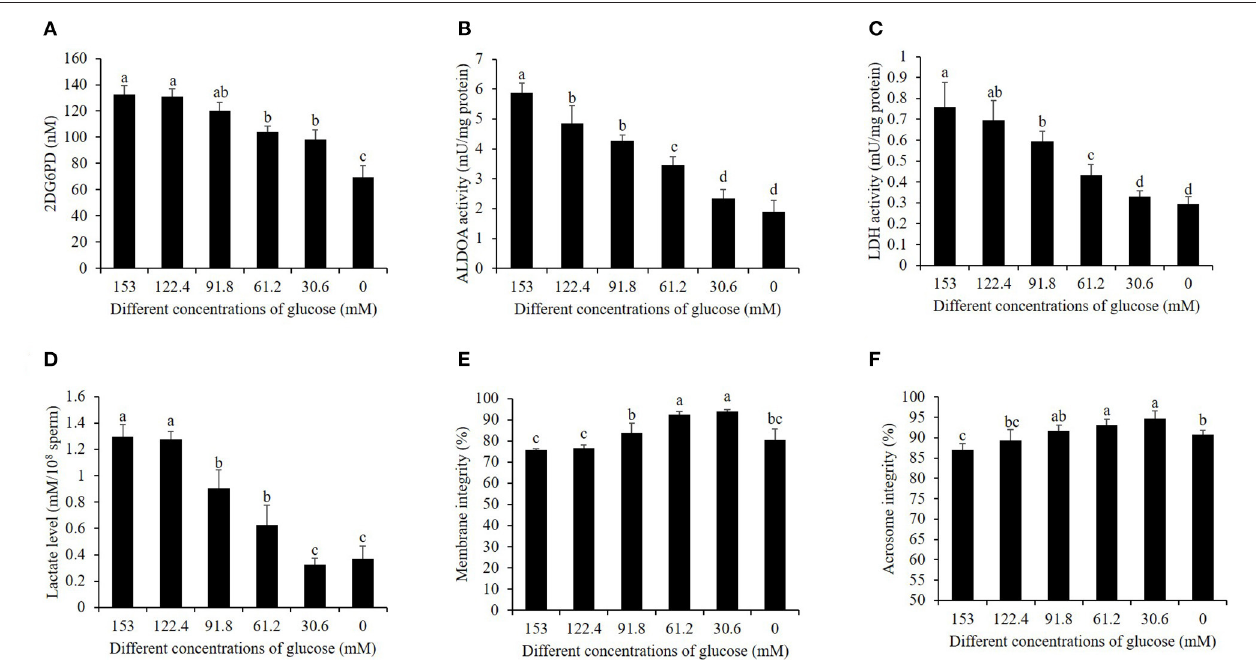
FIGURE 1 | Effects of different glucose levels in the pre-treatment solution on boar sperm hexokinase activity (A) , ALDOA activity (B) , LDH activity (C) , LDH level (D) , membrane integrity (E) , and acrosome integrity (F) during the cooling process. Values are specified as mean ± standard deviation. Columns with different lowercase letters differ significantly ( p < 0.05). ALDOA, aldolase A; LDH, lactate